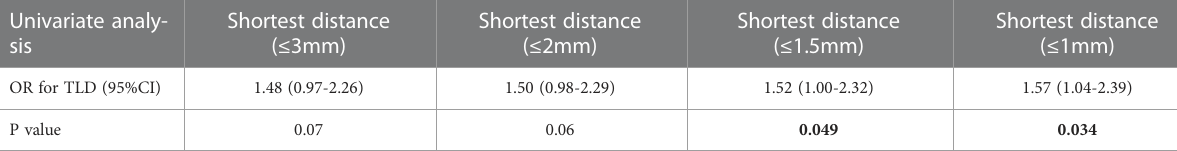
Boldface type indicated statistical signi fi cance.